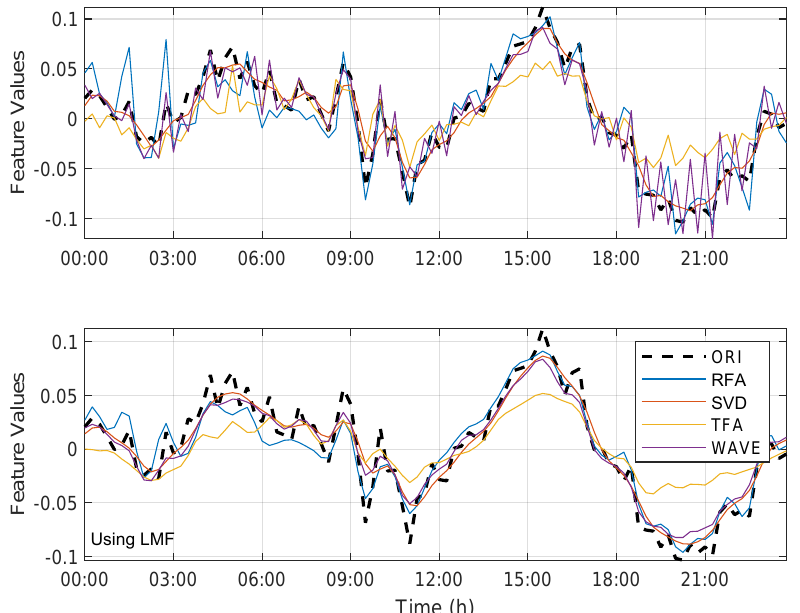
Figure 6. Feature detection results of approach 1 (mean values over one day), top: without LMF (linear mean filter), bottom: using the